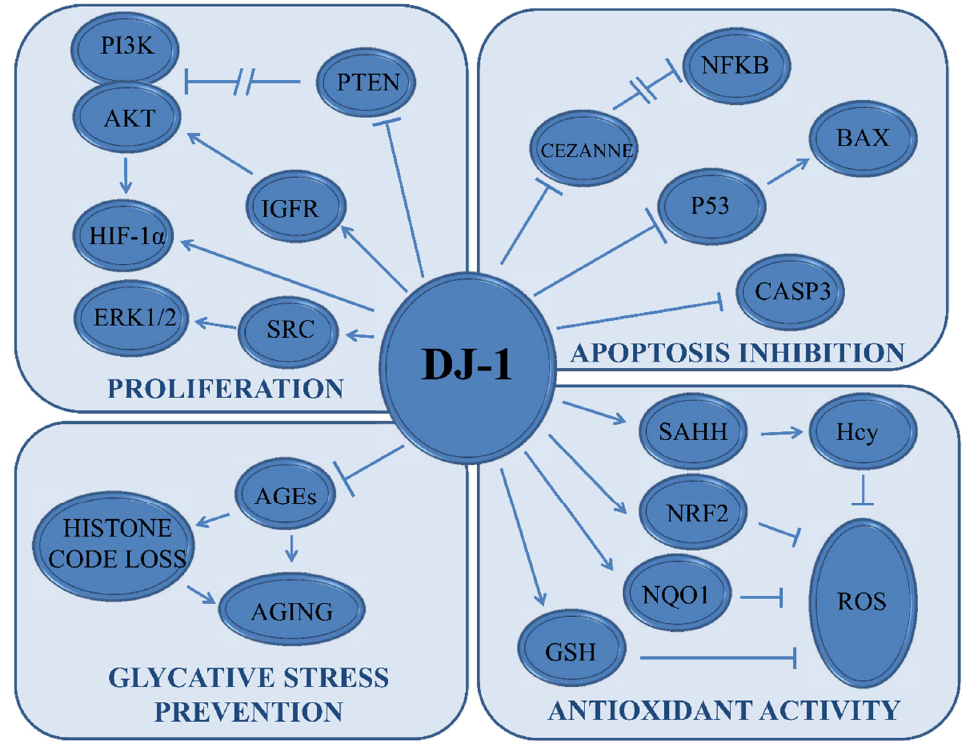
Figure 3. DJ-1 Downstream signaling. The scheme is a synopsis of DJ-1 downstream effectors. DJ-1 is involved in cell proliferation, Apoptosis evasion, redox homeostasis, and prevention of glycative stress. For each signaling pathways, the main effectors are reported. We reported the effects of DJ-1 on phosphatidylinositol-3 kinase (PI3K), protein kinase B (AKT), phosphatase and tensin homolog (PTEN), insulin-like growth factor receptor (IGFR), hypoxia-inducible factor 1-alpha (HIF-1 α ), ex- tracellular signal-regulated kinase 1/2 (ERK1/2), tyrosine-protein kinase (SRC), nuclear factor kappa-light-chain-enhancer of activated B cells (NFKB), cellular zinc finger anti-NF- κ B (CEZANNE), Bcl-2-associated X protein (BAX), (P53), caspase 3 (CASP3), advanced glycation end-products (AGEs), S-adenosyl-homocysteine hydrolase (SAHH), homocysteine (Hcy), nuclear factor erythroid 2-related factor 2 (NRF2), NAD(P)H-quinone oxidoreductase 1 (NQO1), glutathi- one (GSH), and reactive oxygen species (ROS). Some effective approaches for regulating DJ-1 function in cancer have been pub- lished, mostly reporting the interference with its gene expression or pathways modulated by DJ-1. However, studies on the direct blockade of DJ-1 at the protein level are still controversial and need to go more in-depth. One of the major issues is represented by the lack of a potent and ascertained DJ-1 inhibitor. Some studies reported the interaction of a few compounds with the region responsible of DJ-1 homodimerization, demonstrating that its blockade induces cancer cells death. Unfortunately, these outcomes still have many unanswered questions regarding the ability of DJ-1 to form many complexes, its subcellular localization, and the adopted cell context. Thus, it is desirable to enlarge these results in other cancer types and under different experimental conditions, and, most importantly, the current research should focus on the individuation of the DJ-1 com- plexes and its subcellular interactions, the exact role under oxidative stress, and in chemoresistance. Overall, our review aims to underlie that DJ-1 is functionally required for several aspects of the transformed phenotype and suggests that disrupting its protective activity may be a promising therapeutic approach in the fight against cancer. Table 1. Correlating the expression and the regulation of DJ-1 with different types of cancers